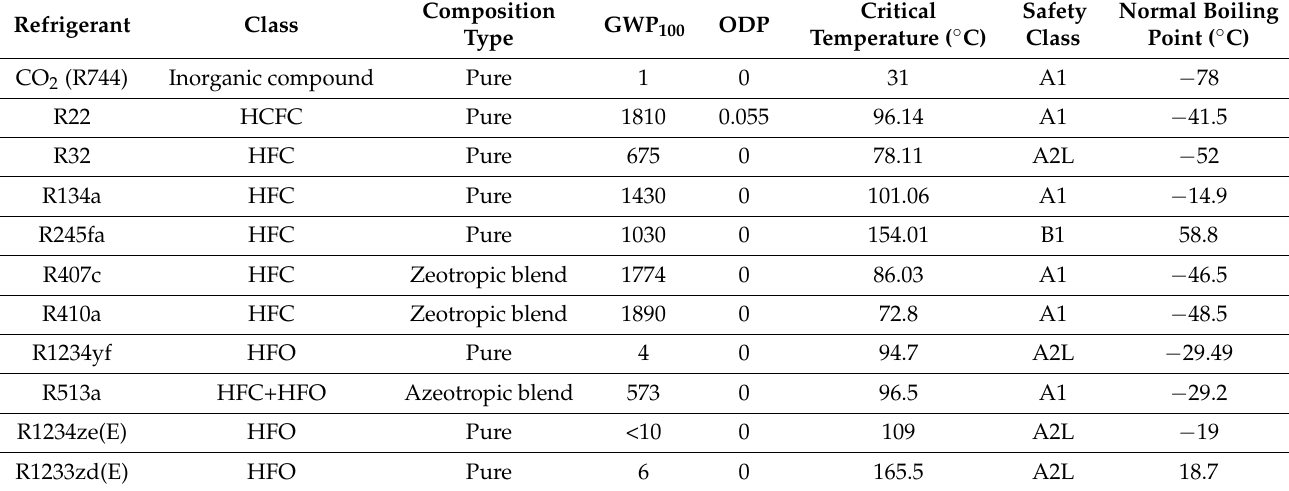
Table 1. Comparison of thermophysical properties of pure and blended refrigerants.